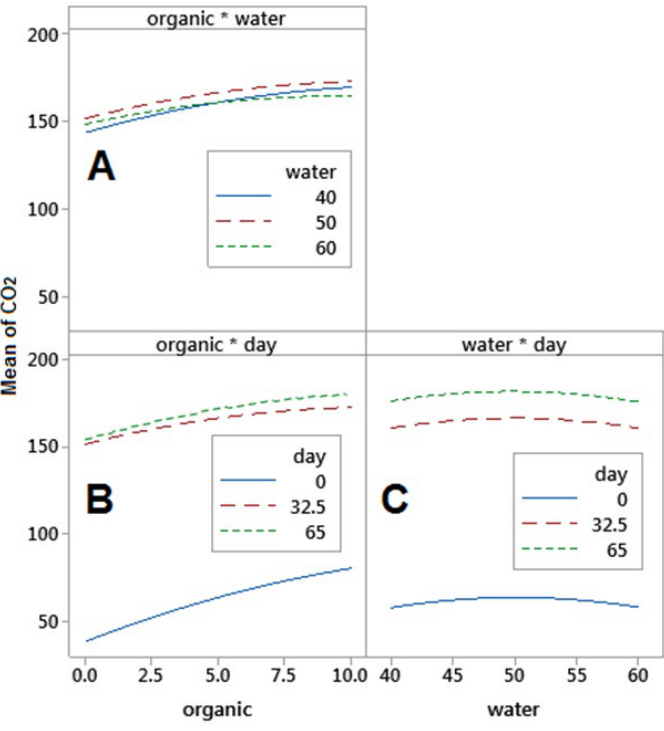
Figure 3. Fitted means factorial interaction plots of CO2 fluxes in calcareous saline soils. (A) represents organic matter and water availability interaction; (B) represents organic matter and incubation period interaction; and (C) represents water availability and incubation period